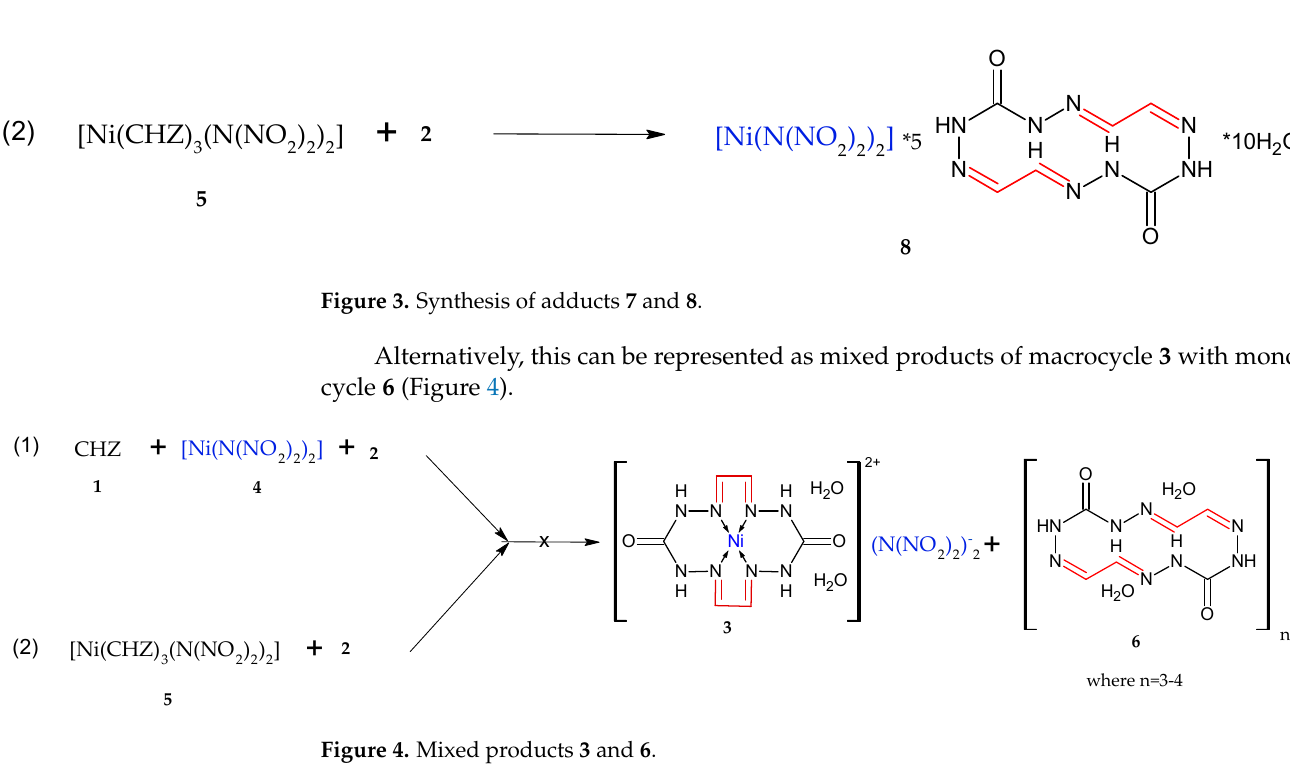
Figure 4. Mixed products 3 and 6.